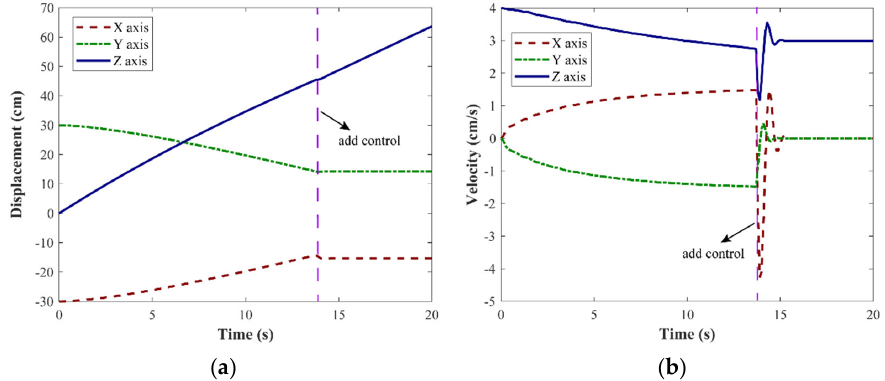
Figure 8. Position and velocity variations of the first actuator during the capture process. ( a ) Position variations of the first actuator. ( b ) Velocity variations of the first actuator.